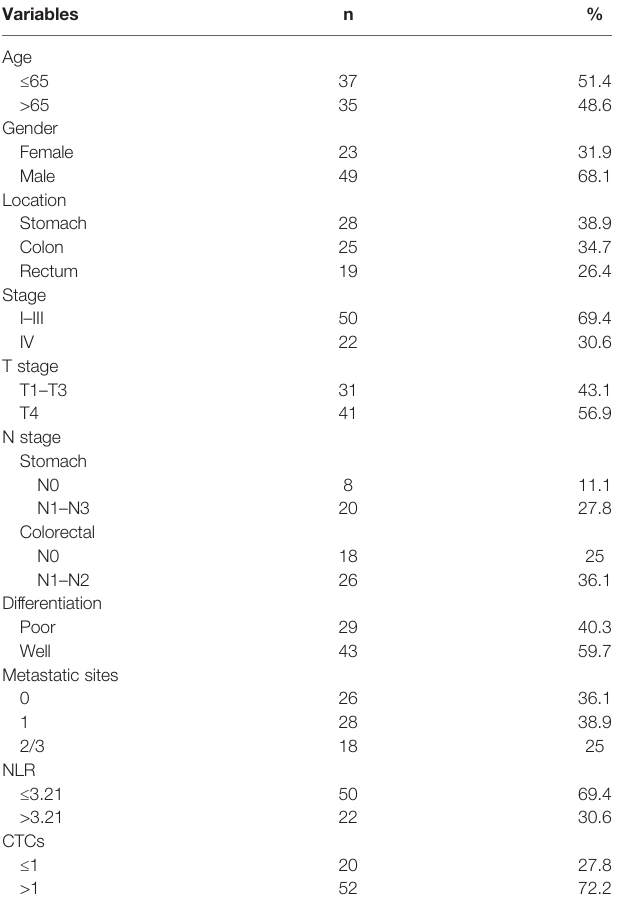
TABLE 1 | Clinicopathological variables of patients with gastrointestinal